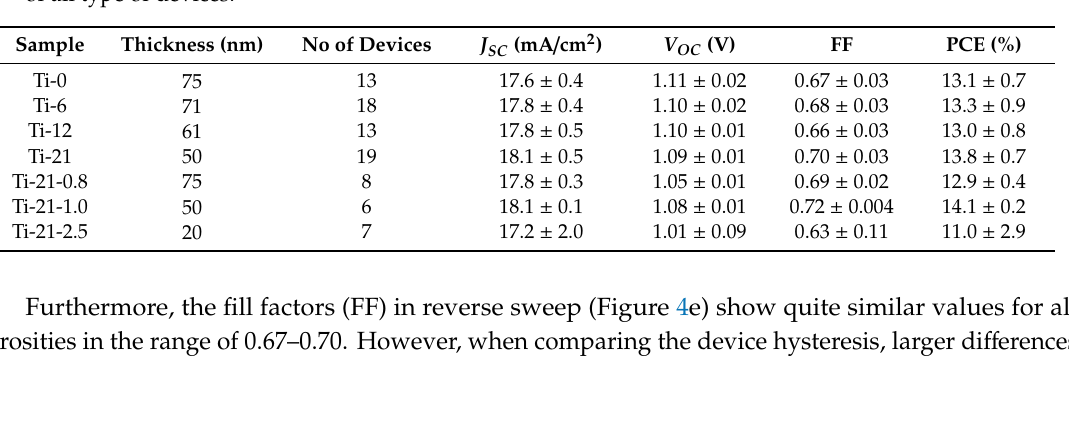
Table 3. Mean values and standard deviations of photovoltaic parameters measured in reverse sweep of all type of